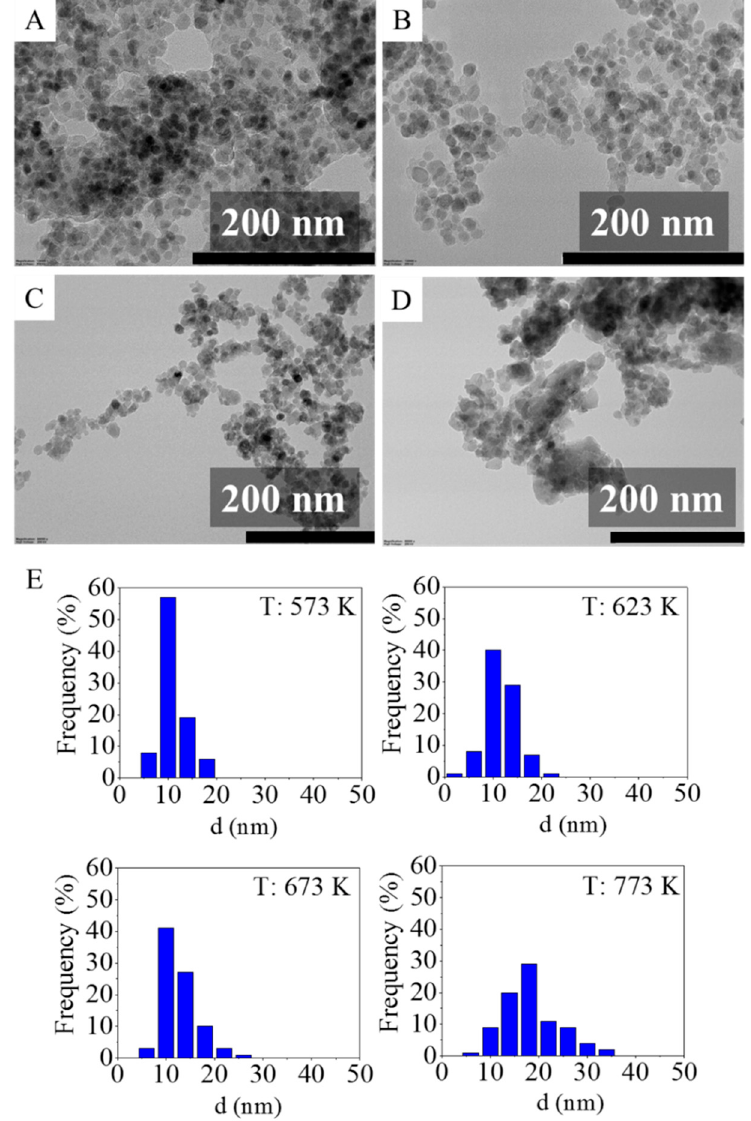
Figure 2. TEM images of the nanoparticles synthesized at 573 K ( A ), 623 K ( B ), 673 K ( C ), and 773 K ( D ), and their size distribution analysis on histograms ( E ). ( D ), and their size distribution analysis on histograms ( E Table 2. Results of the particle size distribution analysis based on TEM images.